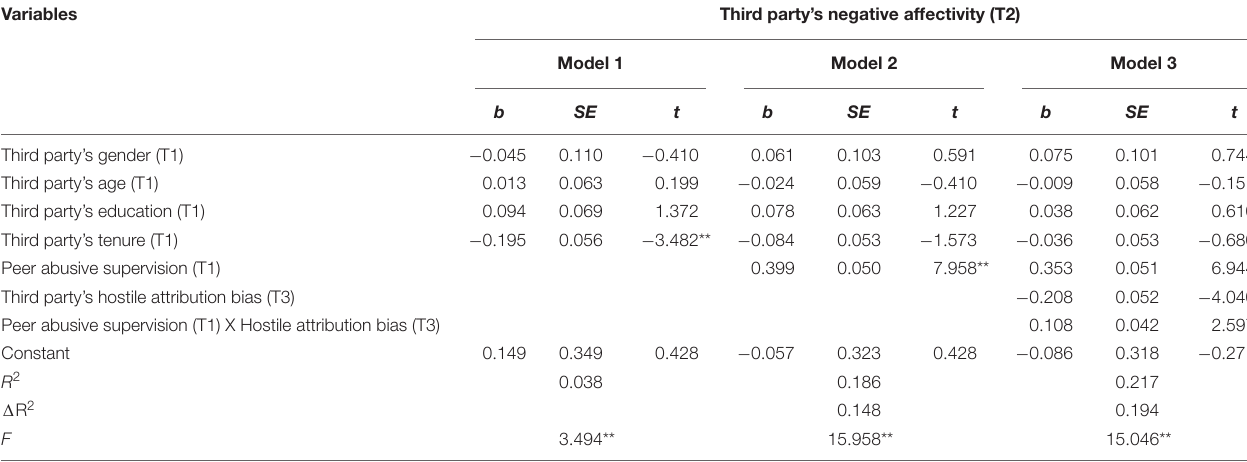
TABLE 6 | Regression results for the predictors of third party’s negative affectivity ( n = 355).